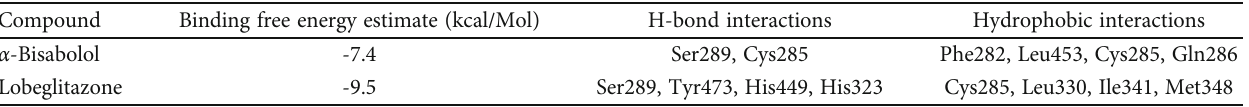
Table 3: Docking